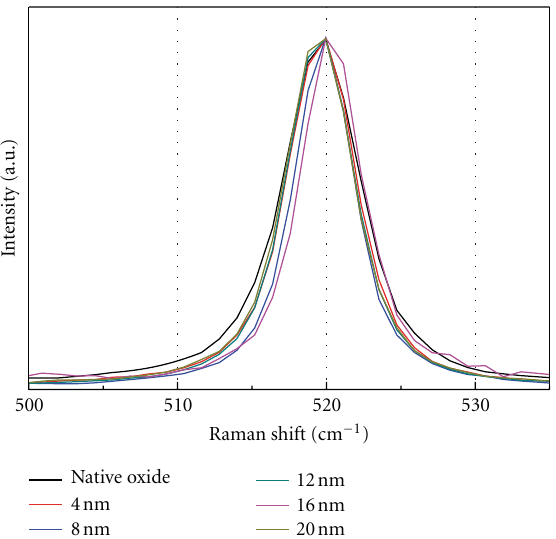
Figure 4: N ormalized Raman spectrum of poly-Si films for various Al oxide layer thickness.